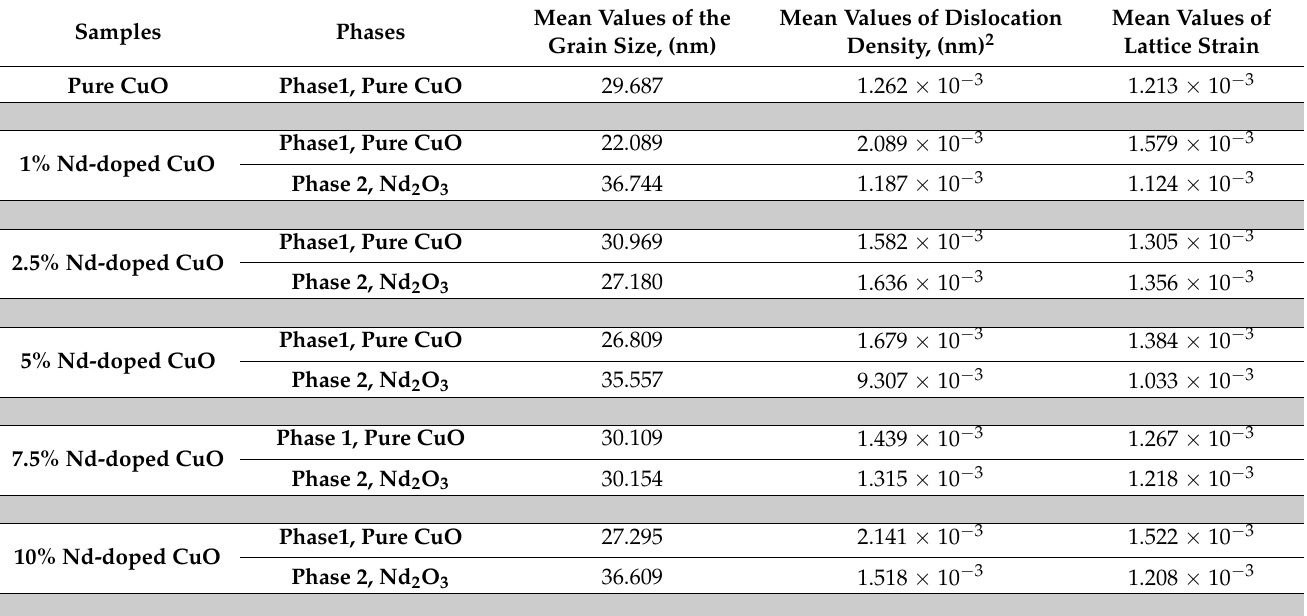
Table 2. The computed mean values of the grain size, dislocation, and strain from the XRD spectra, for all prepared Nd 2 O 3 -CuO